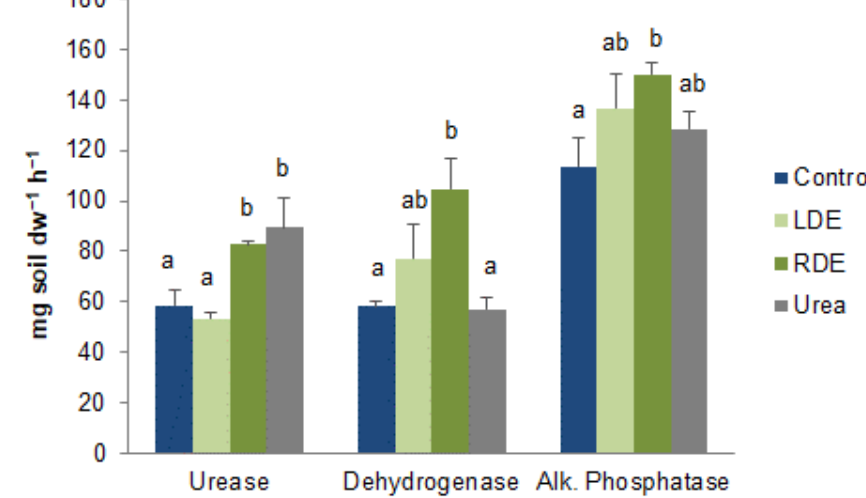
Figure 5. Enzyme activities of soil with fescue pasture upon application of raw (RDE) or lagoon- stored dairy effluent (LDE), urea, or non-amended control. Values represent means ± standard error ( n = 3). Different letters between treatments indicate statistically significant differences ( p < 0.05).